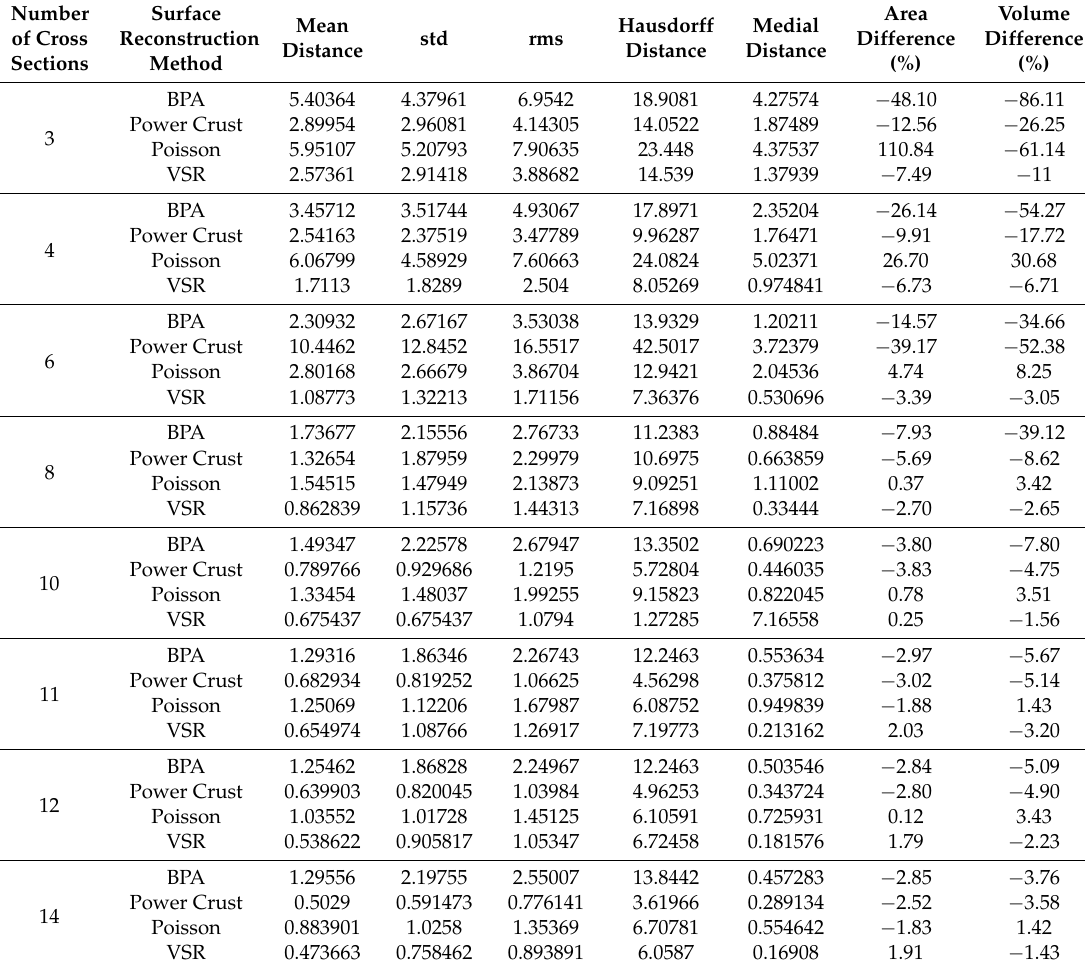
Figure 7. Hausdorff distance between the reconstructed surface and the original surface (HUMAN KIDNEY). Table 2. Difference between the reconstructed surface and the original surface (HUMAN KIDNEY). Number of Cross Sections